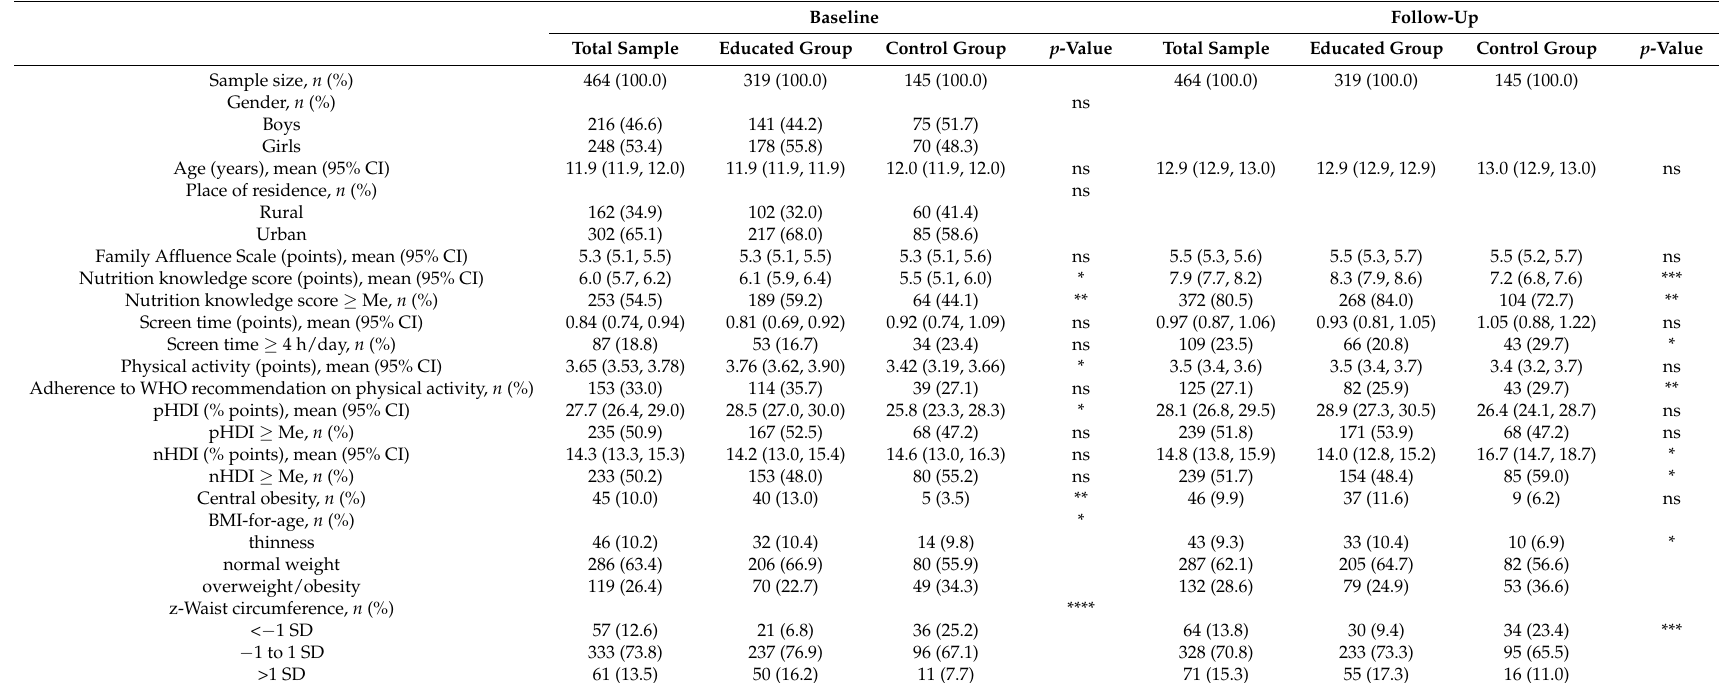
Table 1. Sample baseline characteristics and at a nine-month